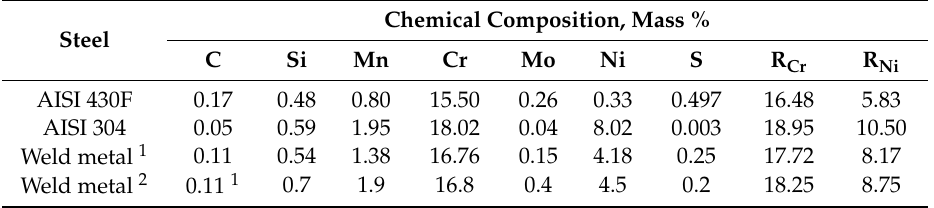
Figure 11. Schaeffler constitutional diagram: ( a ) general view, ( b ) enlarged view. Table 3. Chemical composition of base metals (OES) and weld metal (arithmetic mean of the chemical composition of base metals and EDS analysis).